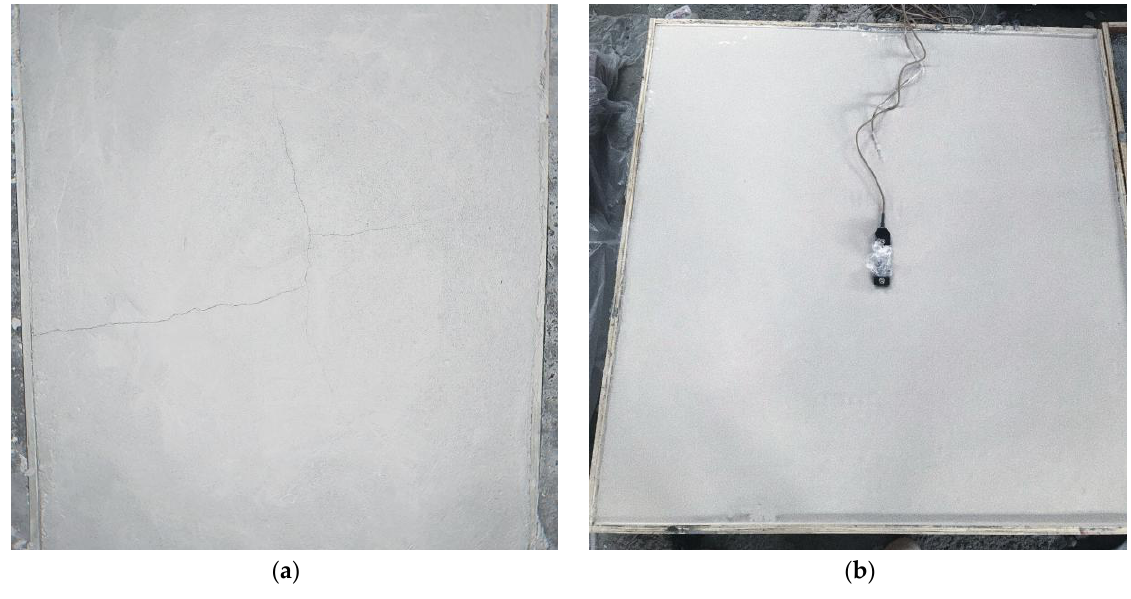
Figure 9. Cracking condition of S0 and S1: ( a ) S0; ( b ) S1.